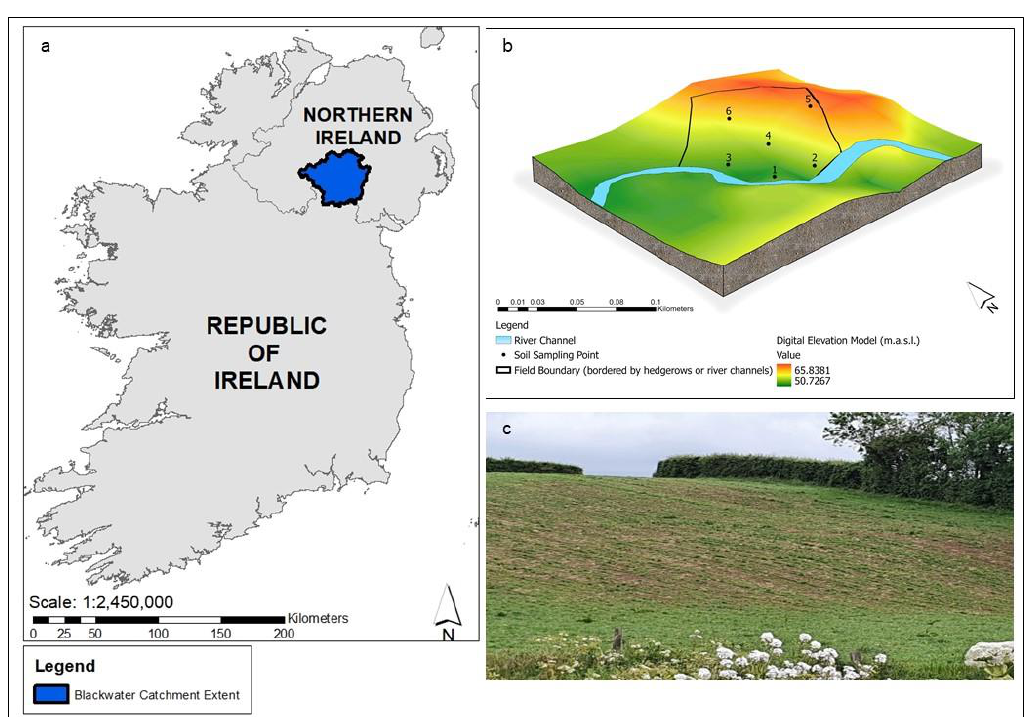
Figure 1. ( a ) the location of the Blackwater catchment within the island of Ireland, ( b ) topographic scene with field boundaries and river channel outlined, and ( c ) conditions of the study site in June 2020 following inversion tillage and reseeding.